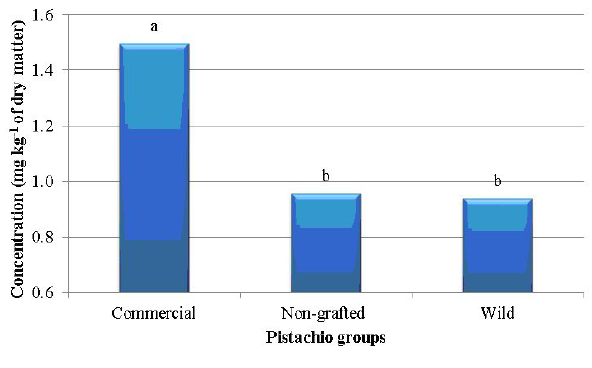
Fig. 6. The nickel concentration of three Iranian pistachio groups. (Each column with different letters is significantly dif- ferent (P <